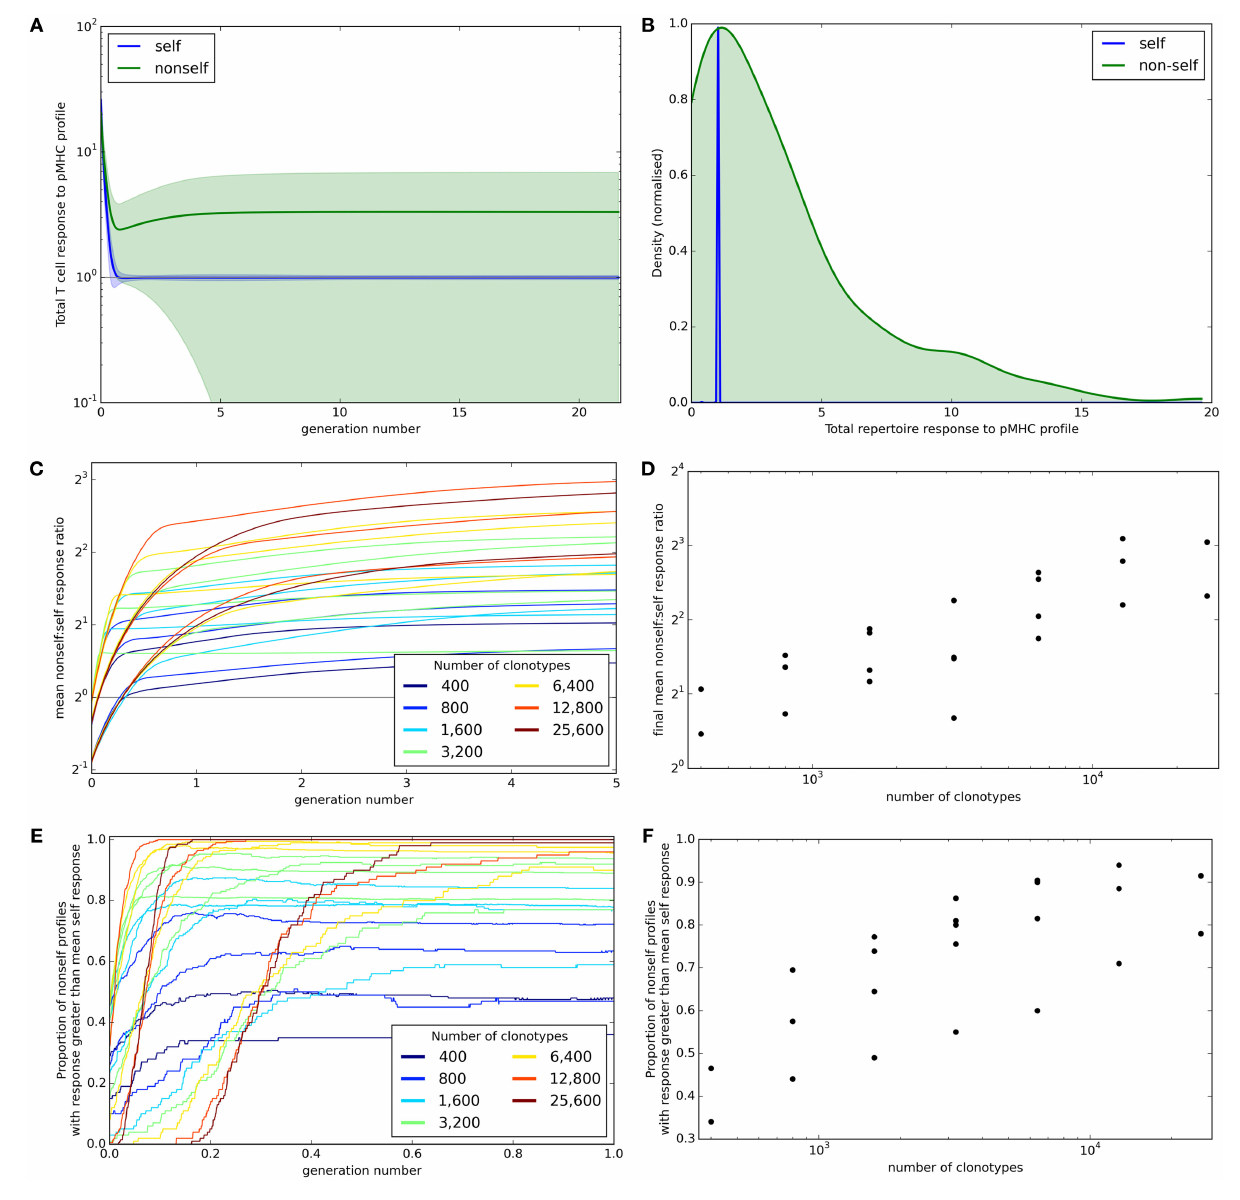
FIGURE 3 | Broad coverage to non-self is maintained during the development of a self-tolerance repertoire . (A) The mean ( (cid:6) standard deviation) total T cell response to self (blue) or non-self (green) pMHC profiles over time with N = 2,000 and M = 200. (B) After 30,000 iterations of the update algorithm with parameters as in (A) , the distribution of total T cell response to self (blue) and non-self (green) pMHC profiles. (C) The ability of the repertoire to successfully mount an immune response to non-self pMHC profiles, measured as the average total response to a non-self profile divided by the average total response to a self profile, over time. The number of T cell clonotypes in a simulation is indicated by color, with the number of self profiles simulated ranging between 100 and 800. (D) The relationship